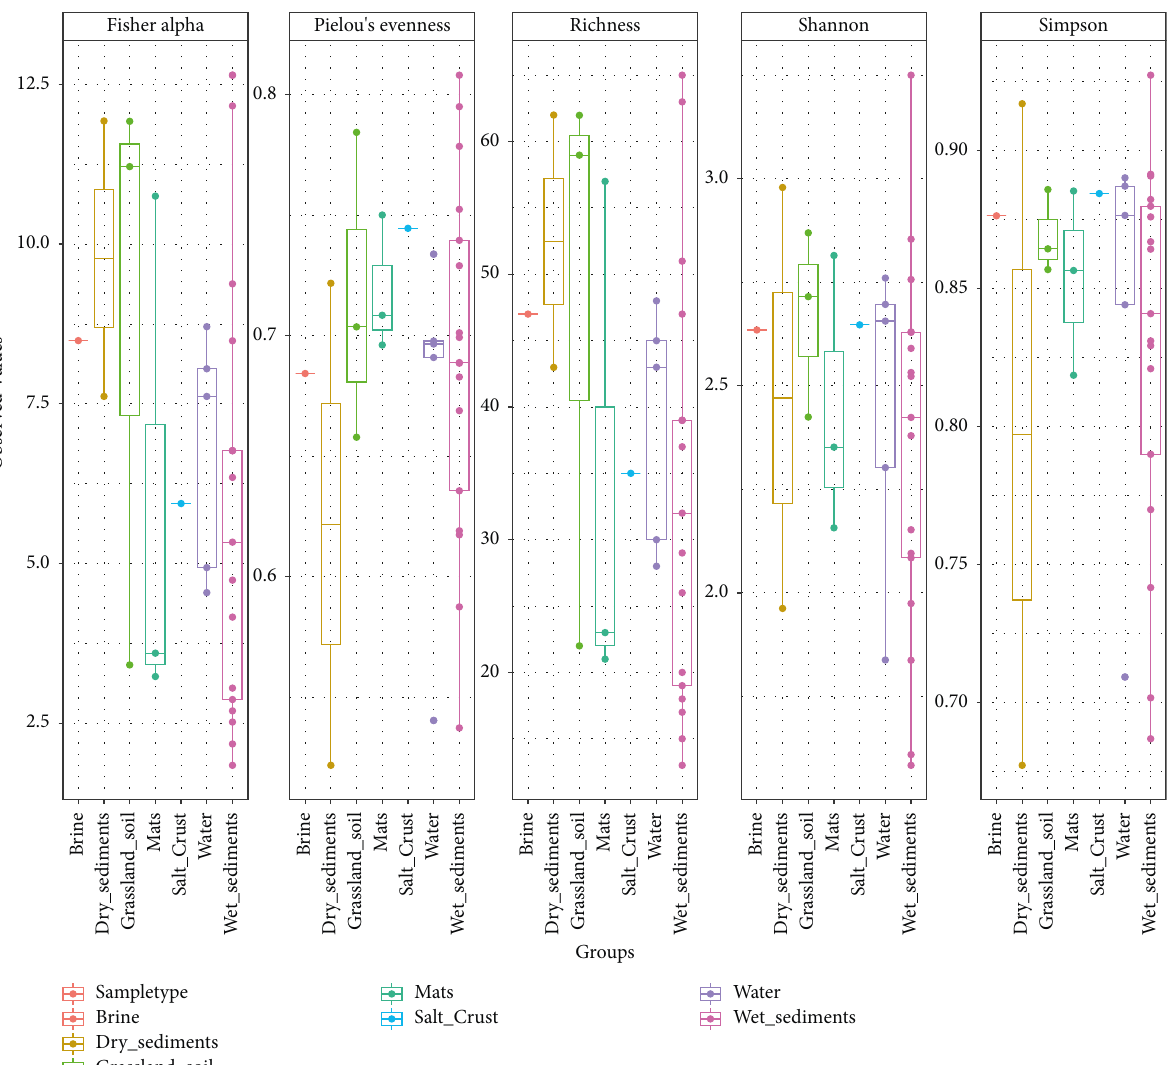
Figure 3: Alpha diversity indices across the samples based on richness, Simpson, Shannon, evenness, and